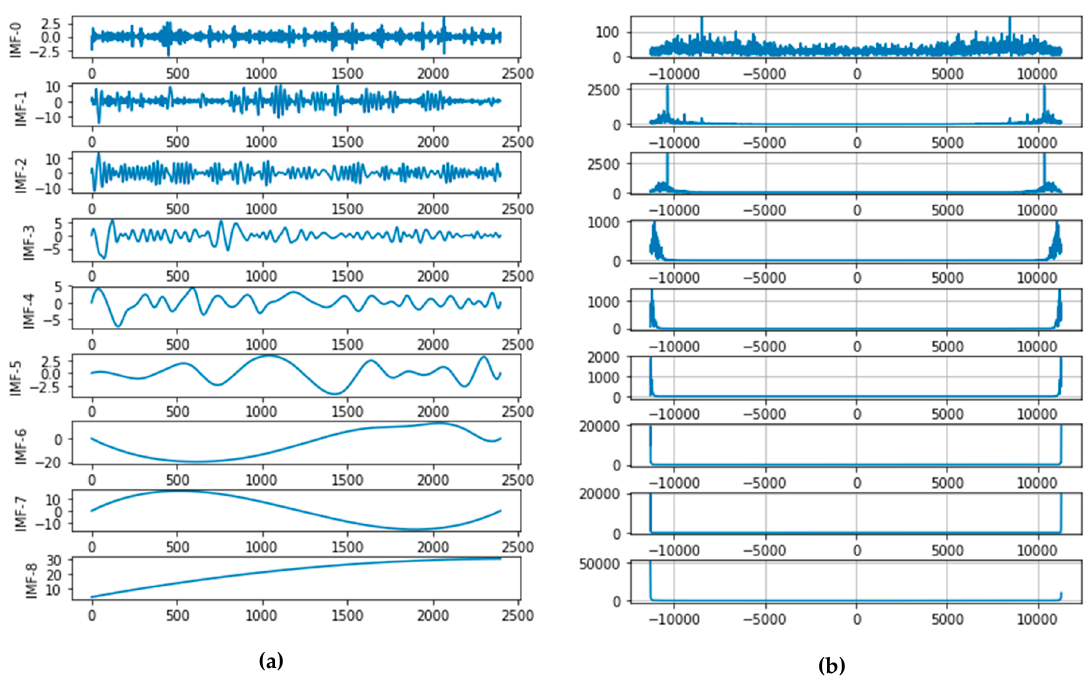
Figure 2. Correspondence of each mode function (IMF) between time and frequency domains after decomposition. IMFs in the ( a ) time domain and ( b ) frequency domain.